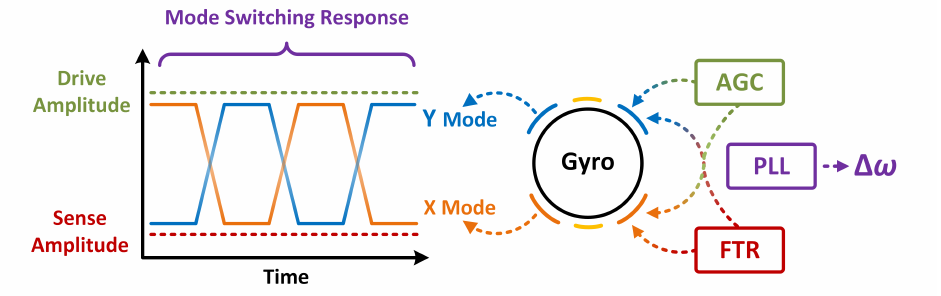
Figure 4. The process of mode